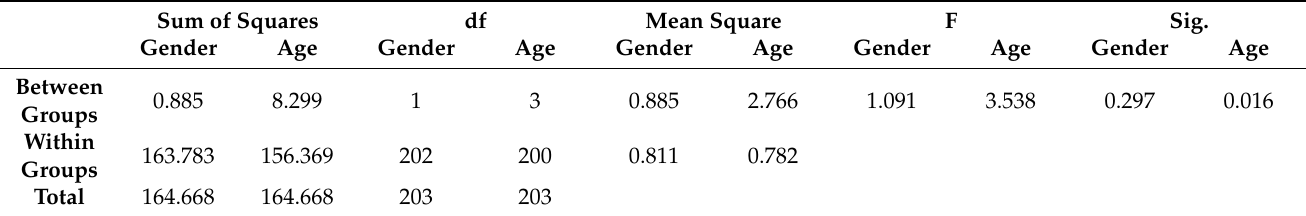
Table 9. ANOVA of Gender and Age.